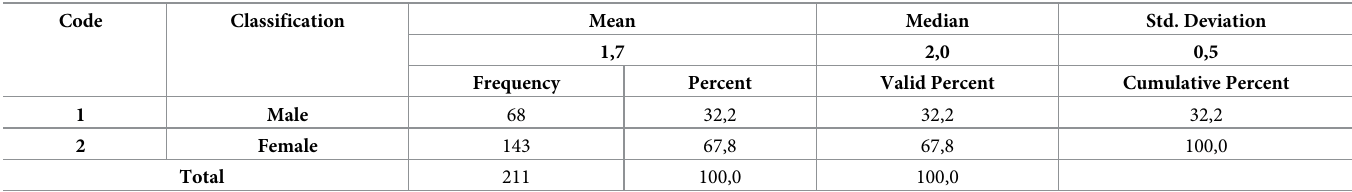
Table 3. Gender distribution of respondents.